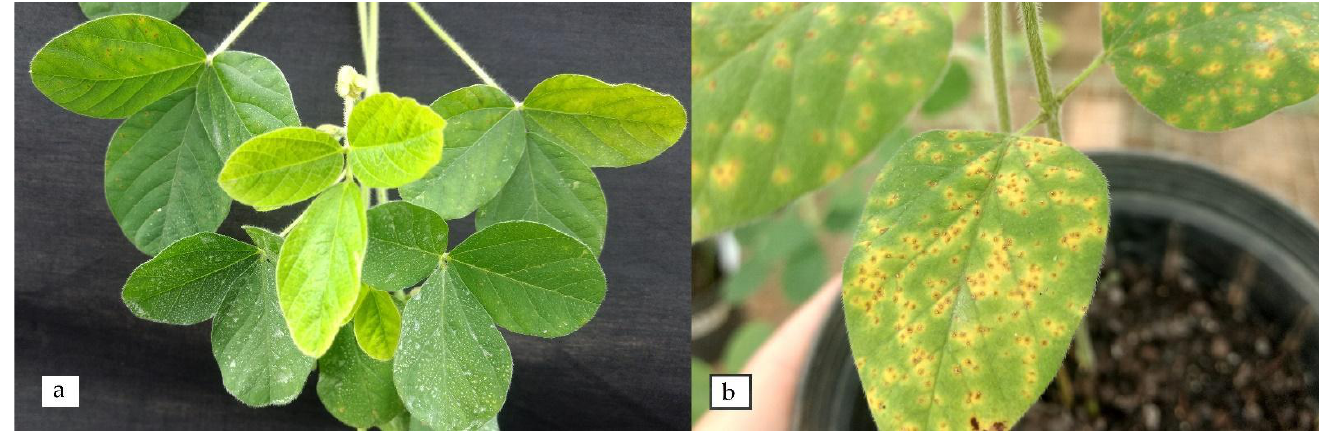
of enzymatic activity even in the absence of cells (BS), but the absence of biosurfactants leads to an increase in rust severity.